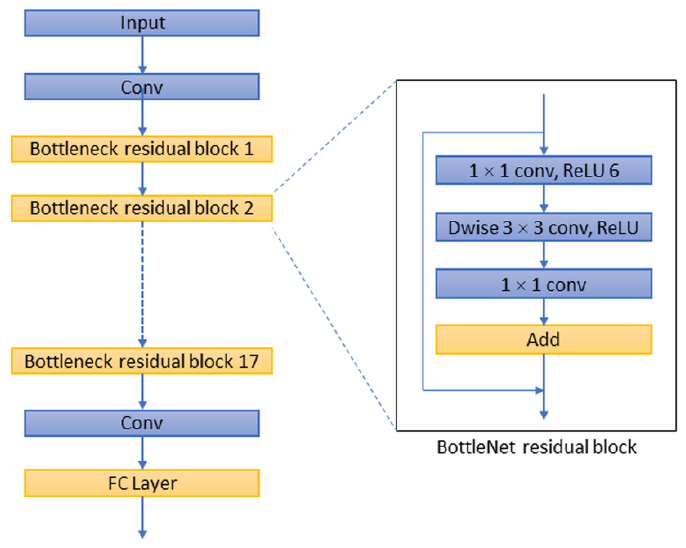
Figure 6. Network architecture of MobileNet-V2.